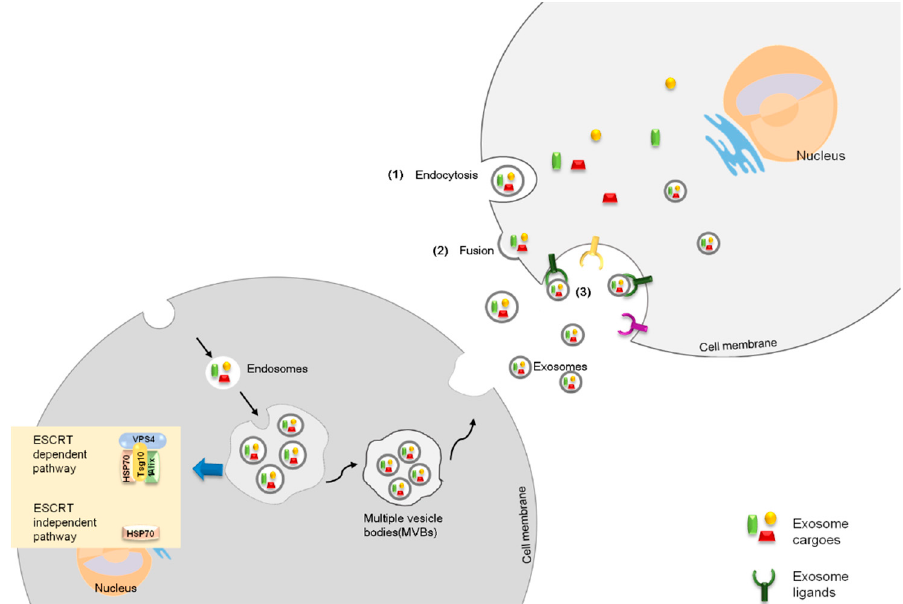
Figure 1. Exosome biogenesis and regulation. Schematic representation of exosome biogenesis and uptake. Exosomes are initially formed as intraluminal vesicles by multivesicular bodies (MVBs). MVB formation has two mechanisms. The endosomal sorting complex required for transport (ESCRT)-dependent pathway requires a complex constituent of ESCRT, Vps4 (vacuolar protein sorting-associated protein), and Hsp70 (heat-shock protein). The typical proteins Tsg101 and Alix for exosome identification belong to the ESCRT complex and represent ESCRT. The other pathway involves ESCRT-independent pathways, which are dependent on Hsp70 binding phospholipids to assemble MVBs. After secretion, the recipient cells mainly uptake those exosomes in three ways: ( 1 ) endocytosis, by which exosomes enter into the recipient cell cytosol directly; ( 2 ) fusion, by which the exosome cargo is mainly released to the recipient cytosol; or ( 3 ) ligands, by which exosomes interact with the recipient cells either by inducing internalization or eliciting intracellular signaling cascades without being internalized.